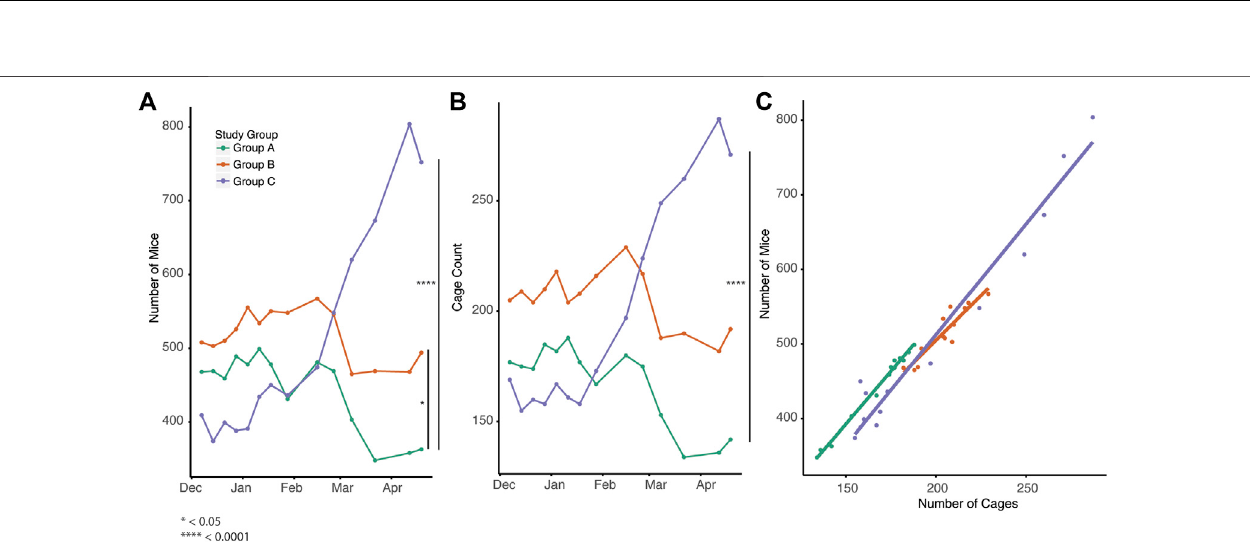
FIGURE2| Breedingmanagementandautomatedgenotypingimpactoverallcolonysize. (A) Totalnumberofmiceforeachgroupoverthetime(Mixedeffectlinear regression, p = 0.0127, 2.66e-07 for Group B and C) (B) Total number of cages for each group over time (Mixed effect linear regression, p = 6.34e-07, Group C) (C) Correlation of number of mice vs. number of cages (Spearman correlation r = 0.924, 0.779, 0.744, p = 4.461 e − 08, 1.392 e − 0.4, 4.021 e − 04 for Group A, B, C).